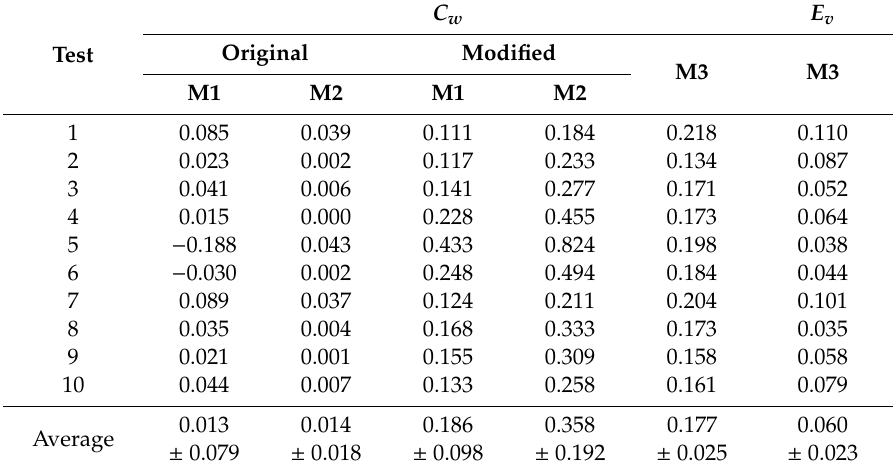
Table 6. Wind e ff ect coe ffi cients C w obtained for the experimental greenhouse according to the original ventilation models M1, M2, and M3 (Equations (1), (2) and (3)) and the modified models M1 and M2 (Equations (13) and (14)). E v , coe ffi cient of the e ff ectiveness of the opening E v = C dM C w0.5 based on model